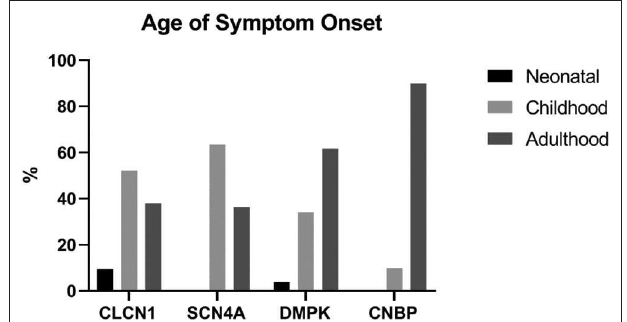
FIGURE 1 | Age range at time of symptom onset by genotype. Neonatal < 1 year old, childhood 1 − 18 years old, adulthood > 18 years